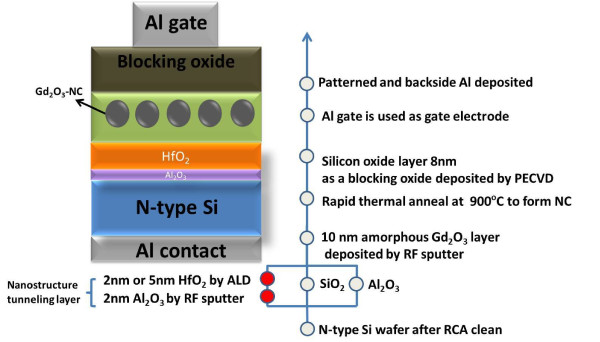
The schematic structure of Gd2O3-NC memories with nanostructure tunneling layer. There are four samples in this experiment. Two samples for the nanostructure HfO2/Al2O3 layer with 2 and 5 nm HfO2, respectively. Two samples for the SiO2 and Al2O3 single tunneling layers, respectively.